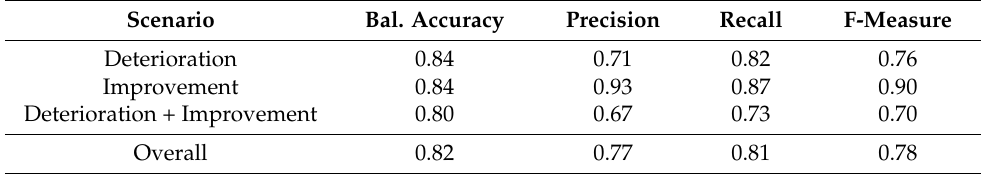
Figure 7. ( a ) Subsequent radiographs belonging to a patient (13) who exhibited deterioration in the scans obtained at days 4, 6, and 9 but slight improvement on day 10 as reflected in ( b ) the disease progression profile (red line). The patient required supplemental oxygen but survived the infection. Table 4. Disease progression detection performance using PEF. Scenario Bal. Accuracy Precision Recall F-Measure Deterioration